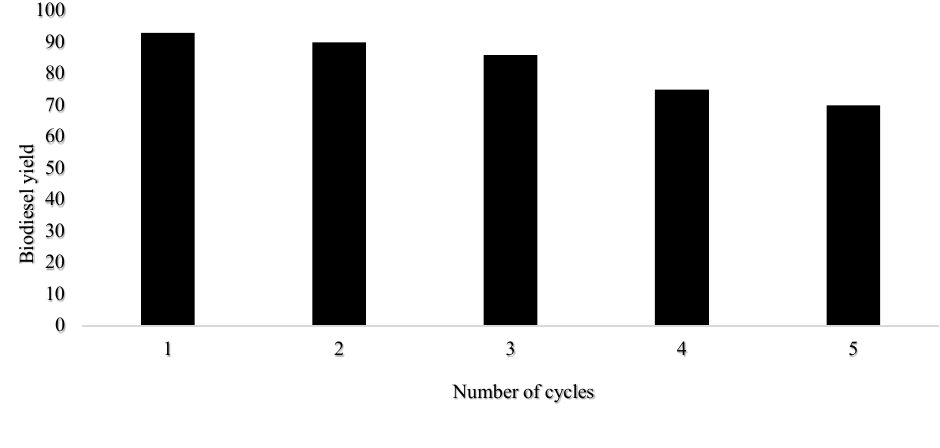
Fig. 6. Effect of reusing the catalyst up to five times on biodiesel